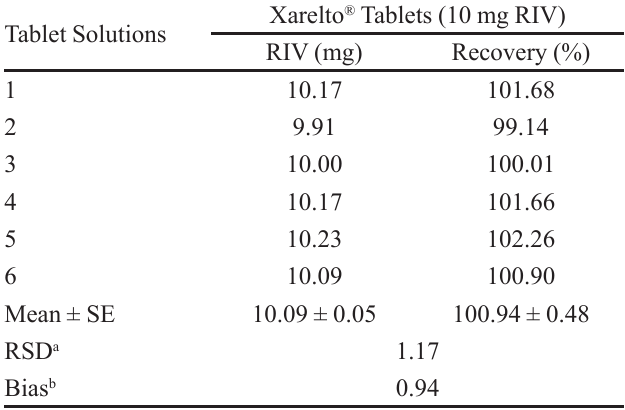
TABLE VI - Tablet analysis results Tablet